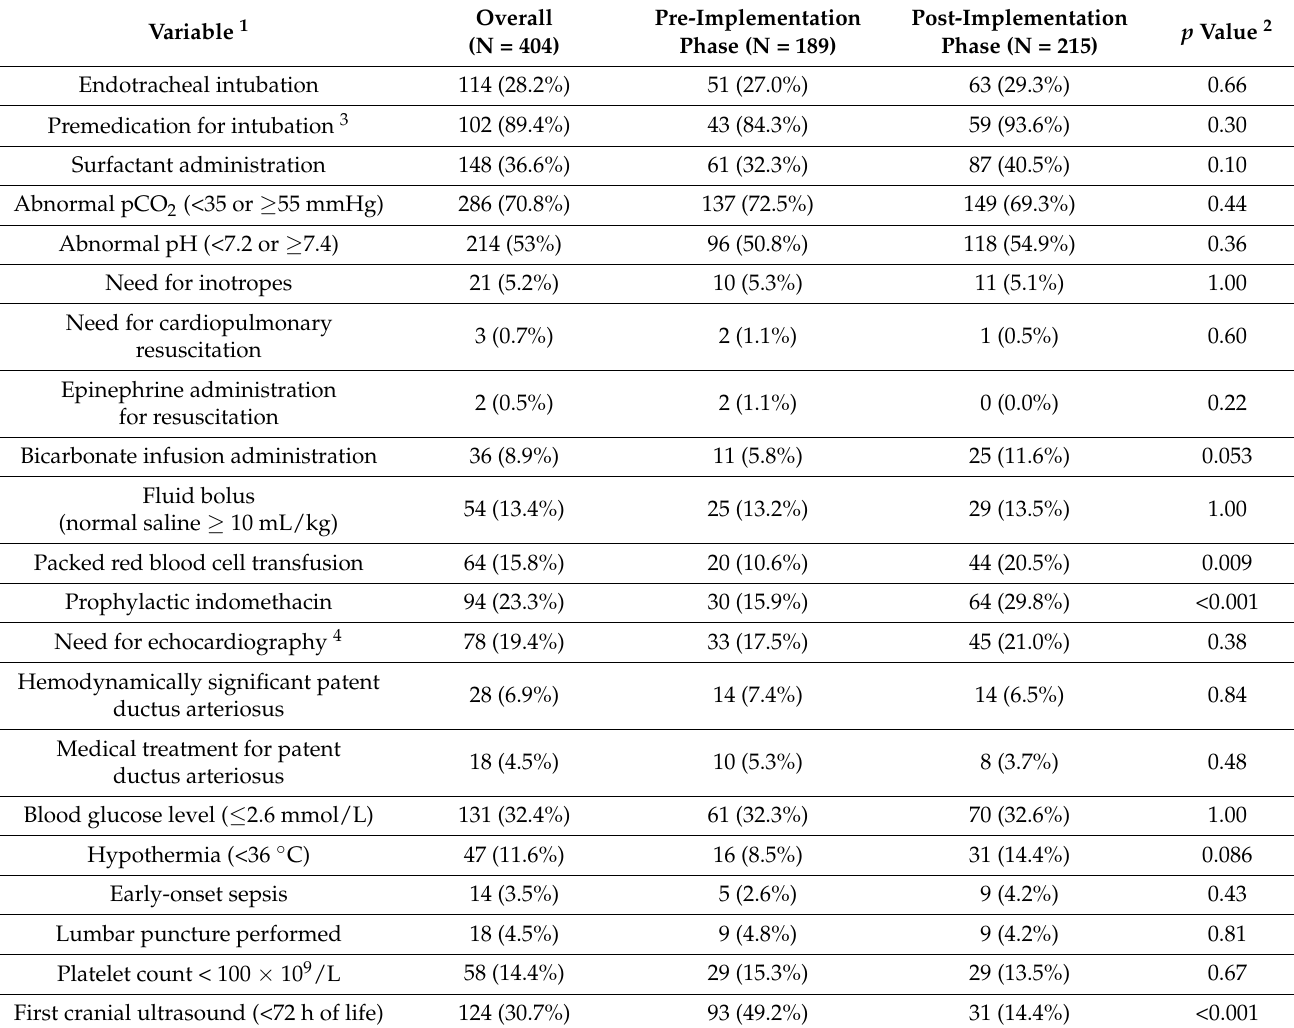
Table 2. Neonatal management characteristics for the first 72 h of